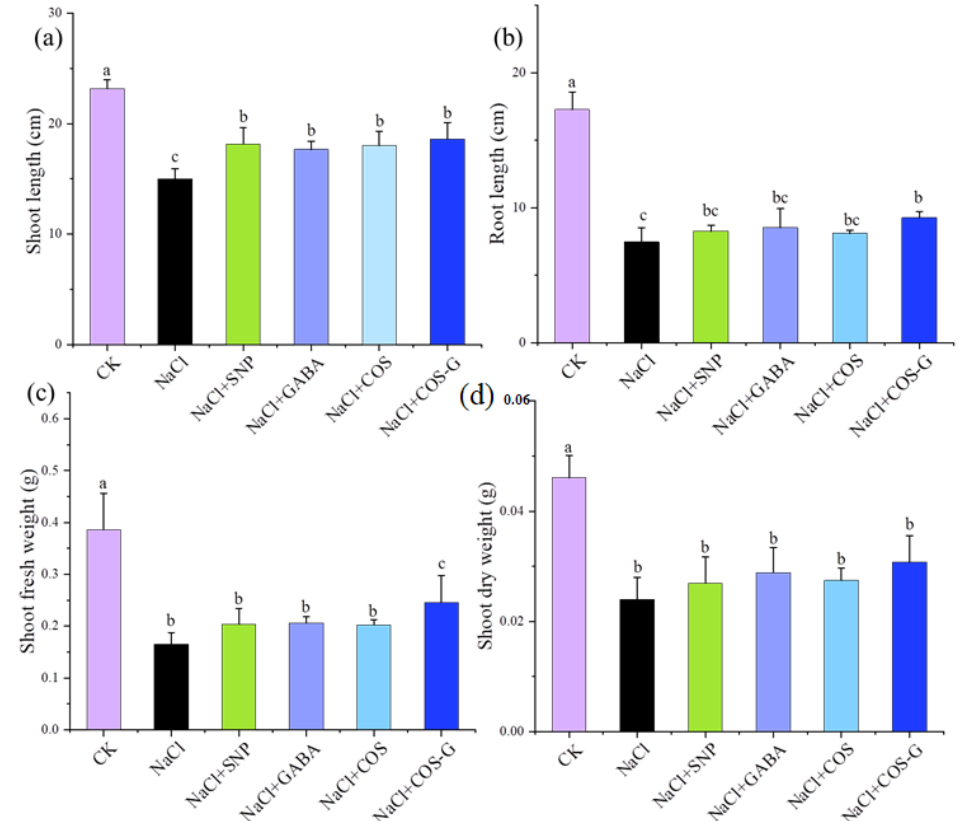
Figure 2. Nuclear magnetic resonance hydrogen spectra of COS ( a ) and COS ‐ G ( b ).